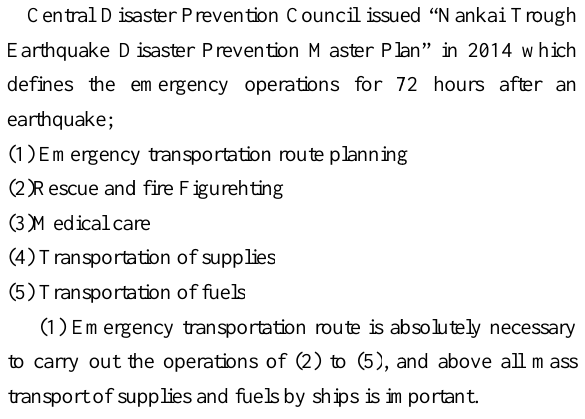
Figure Figure . 14. shows the flow of the coastal area disaster prevention system of MMS + C3D at the time of disaster and prevention system of MMS + C3D at the time of disaster and at normal times. It is imperative to set up time at normal times. It is imperative to set up time actions can be taken as per the disaster prevention master plan.